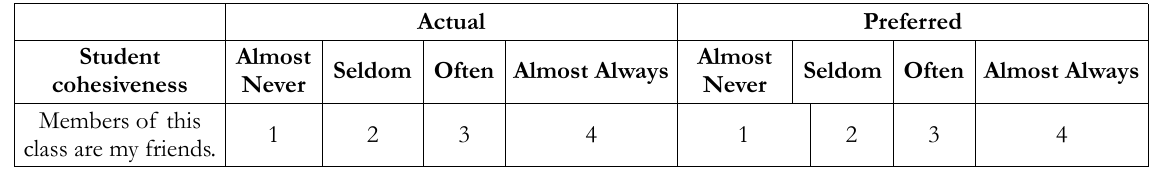
Table 2. Side-by-side response format for actual and preferred responses used in this study Questionnaire